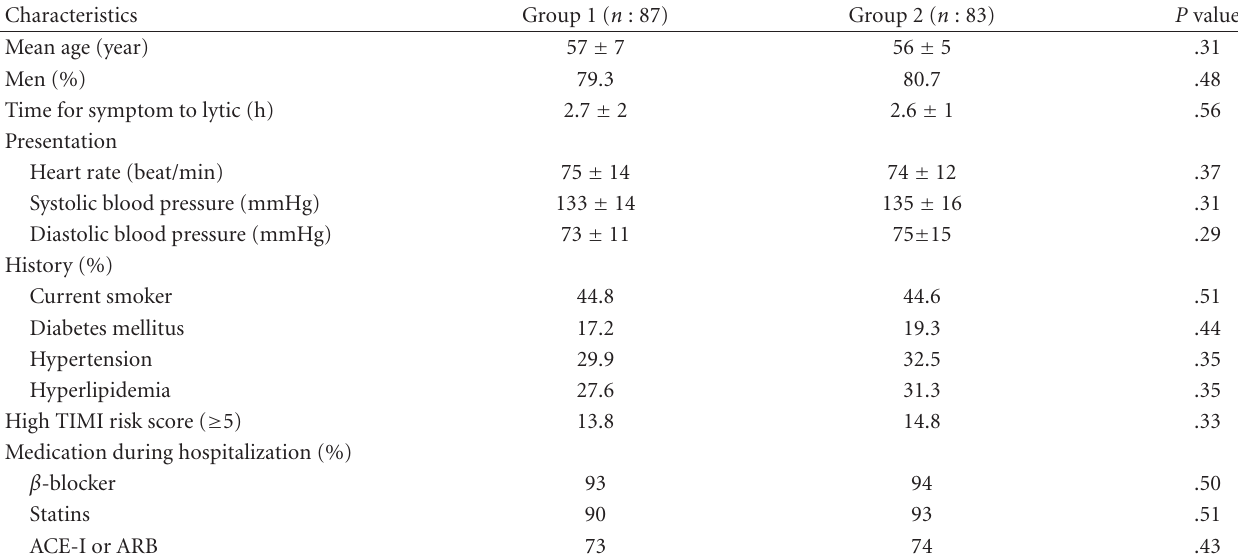
Table 1: Baseline